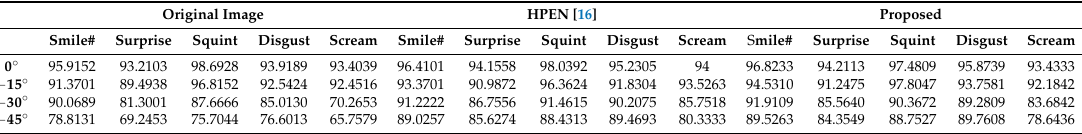
Table 2. Rank-1 recognition rates for Multi-PIE in pose frontalization and expression neutralization with combined pose and expression variations. "Smile#" images are from both session 1 and session